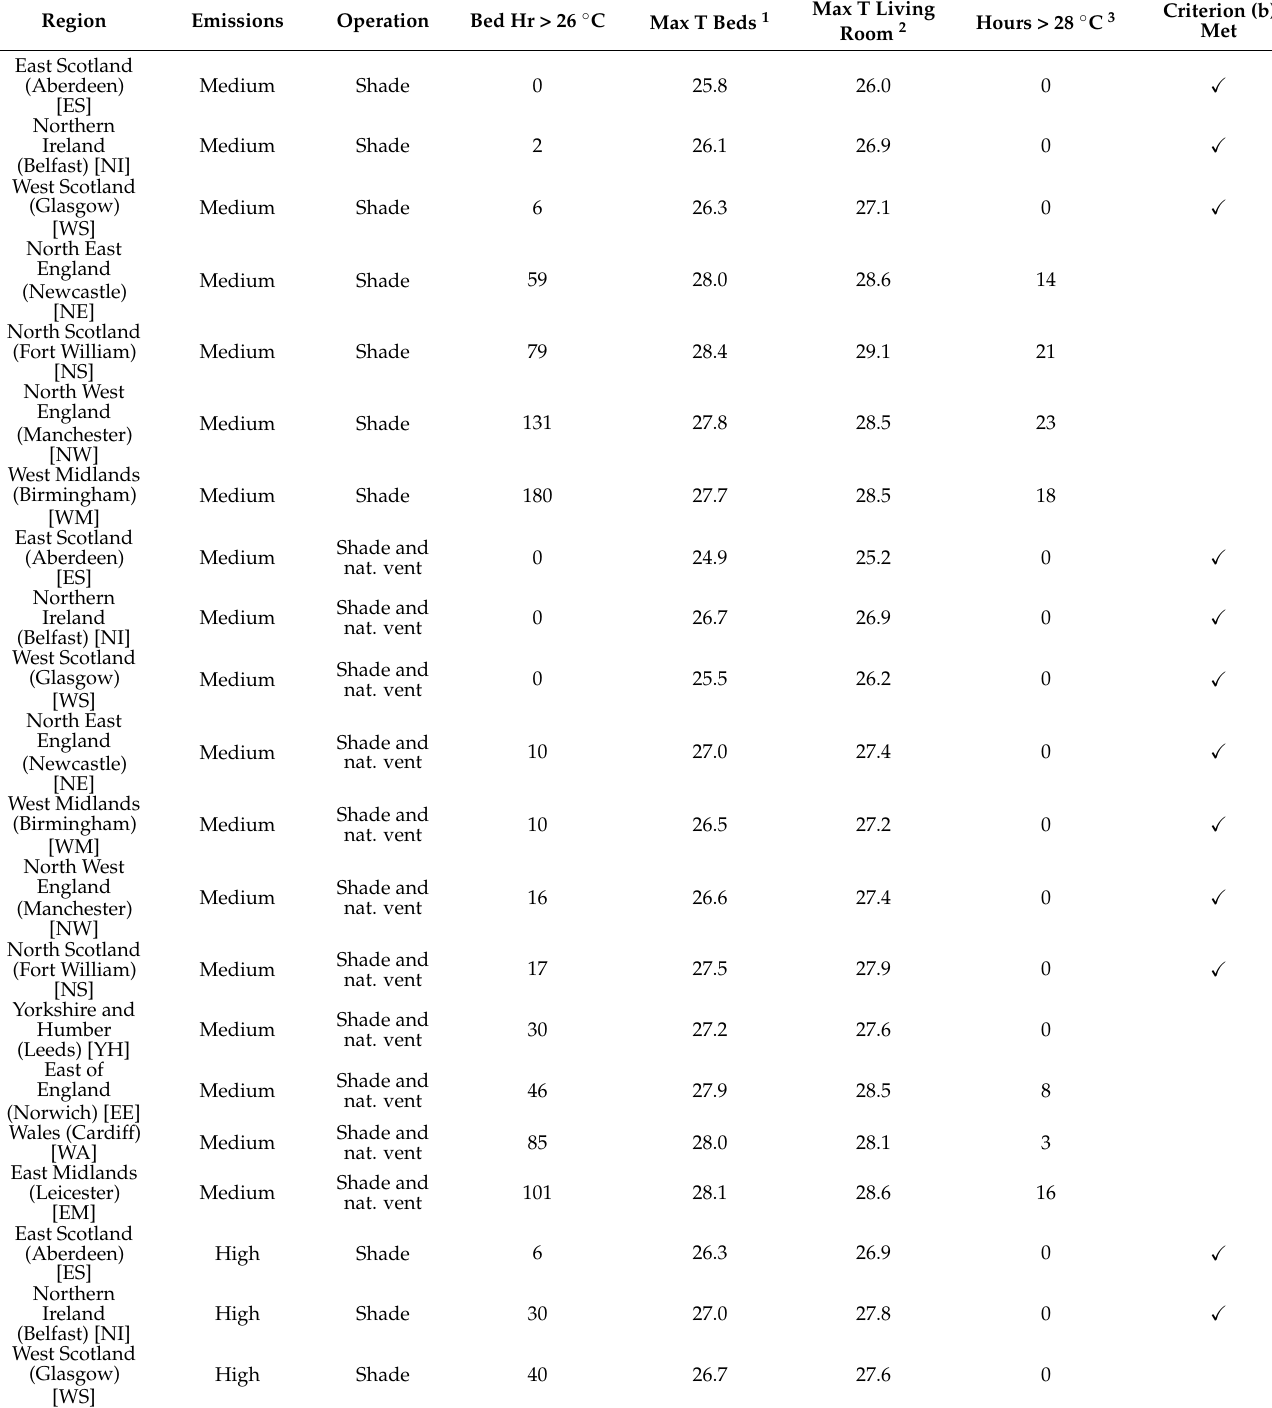
Table 10. Cases for 2080s where bedroom overheating is below 200 h, for shading and shading and natural